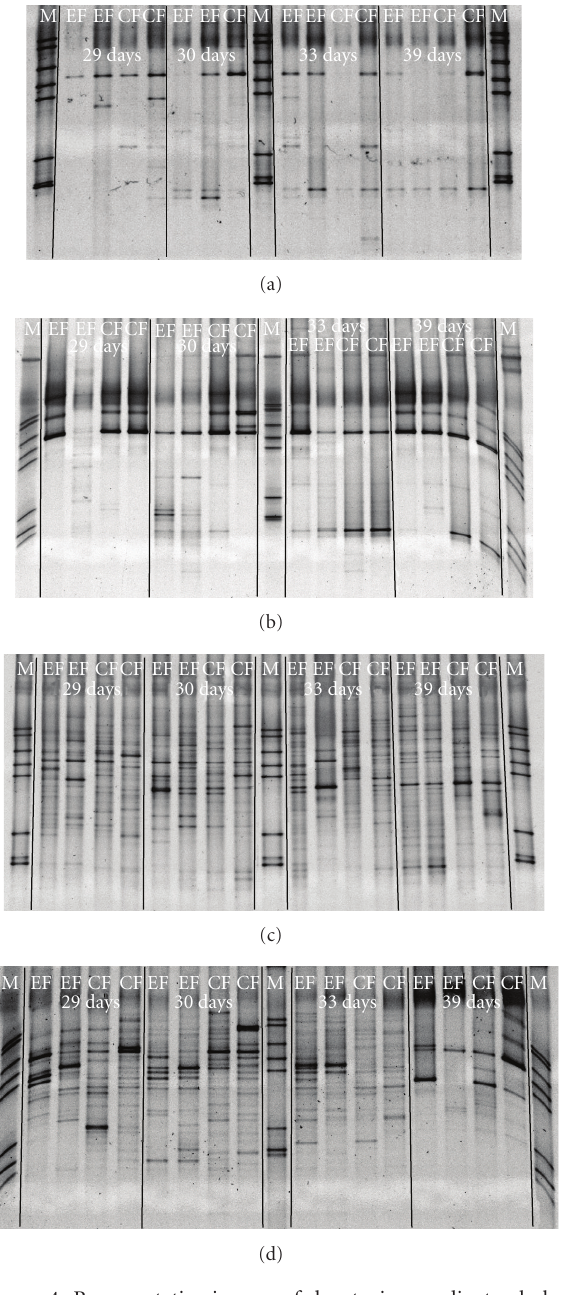
Figure 4: Representative images of denaturing gradient gel elec- trophoresis fingerprints of amplicons of bacterial V6–V8 fragments of 16S rRNA gene obtained from distal small intestinal (a, b) and colonic (c, d) digesta of piglets fed after weaning a starter diet (a, c) with 0 . 04% of essential oils mixture containing limonene, pinene, and eugenol (b, d).